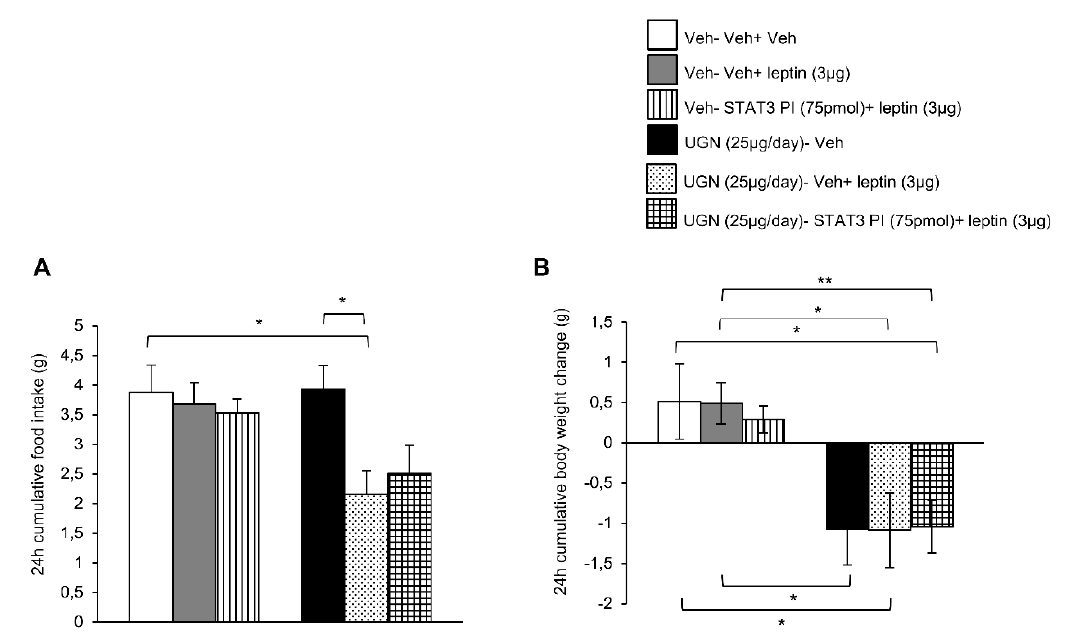
Figure 3. Evaluation of the blockade of STAT3 pathway in the response in 24 h cumulative food intake ( A ) and body weight change ( B ). The mice were perfused with UGN (25 µ g/mouse) for four days, submitted to fasting overnight and then injected with leptin (3 µ g/mouse), an inhibitor of STAT3 (STAT3 PI) (75 pmol/mouse), or by the combination leptin/STAT3 PI. Values are represented as mean ± SEM; n = 10–11 animals per group. * p < 0.05, ** p < 0.01 vs. vehicle.